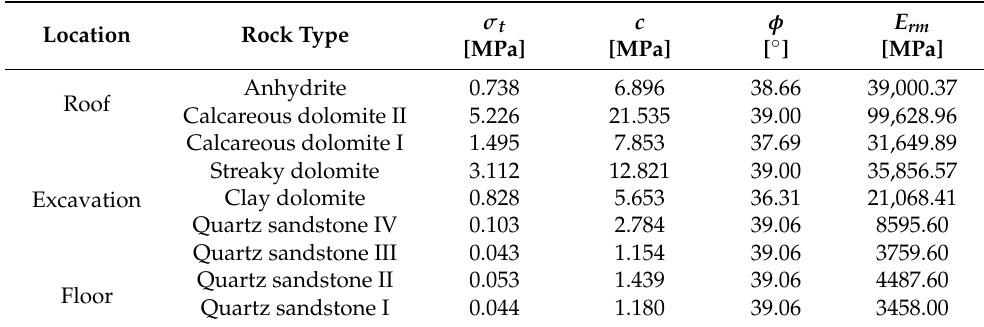
Table 3. Rock mass parameters determined with the RocLab 1.0 application the Jm-06 To-1 measure- ment borehole